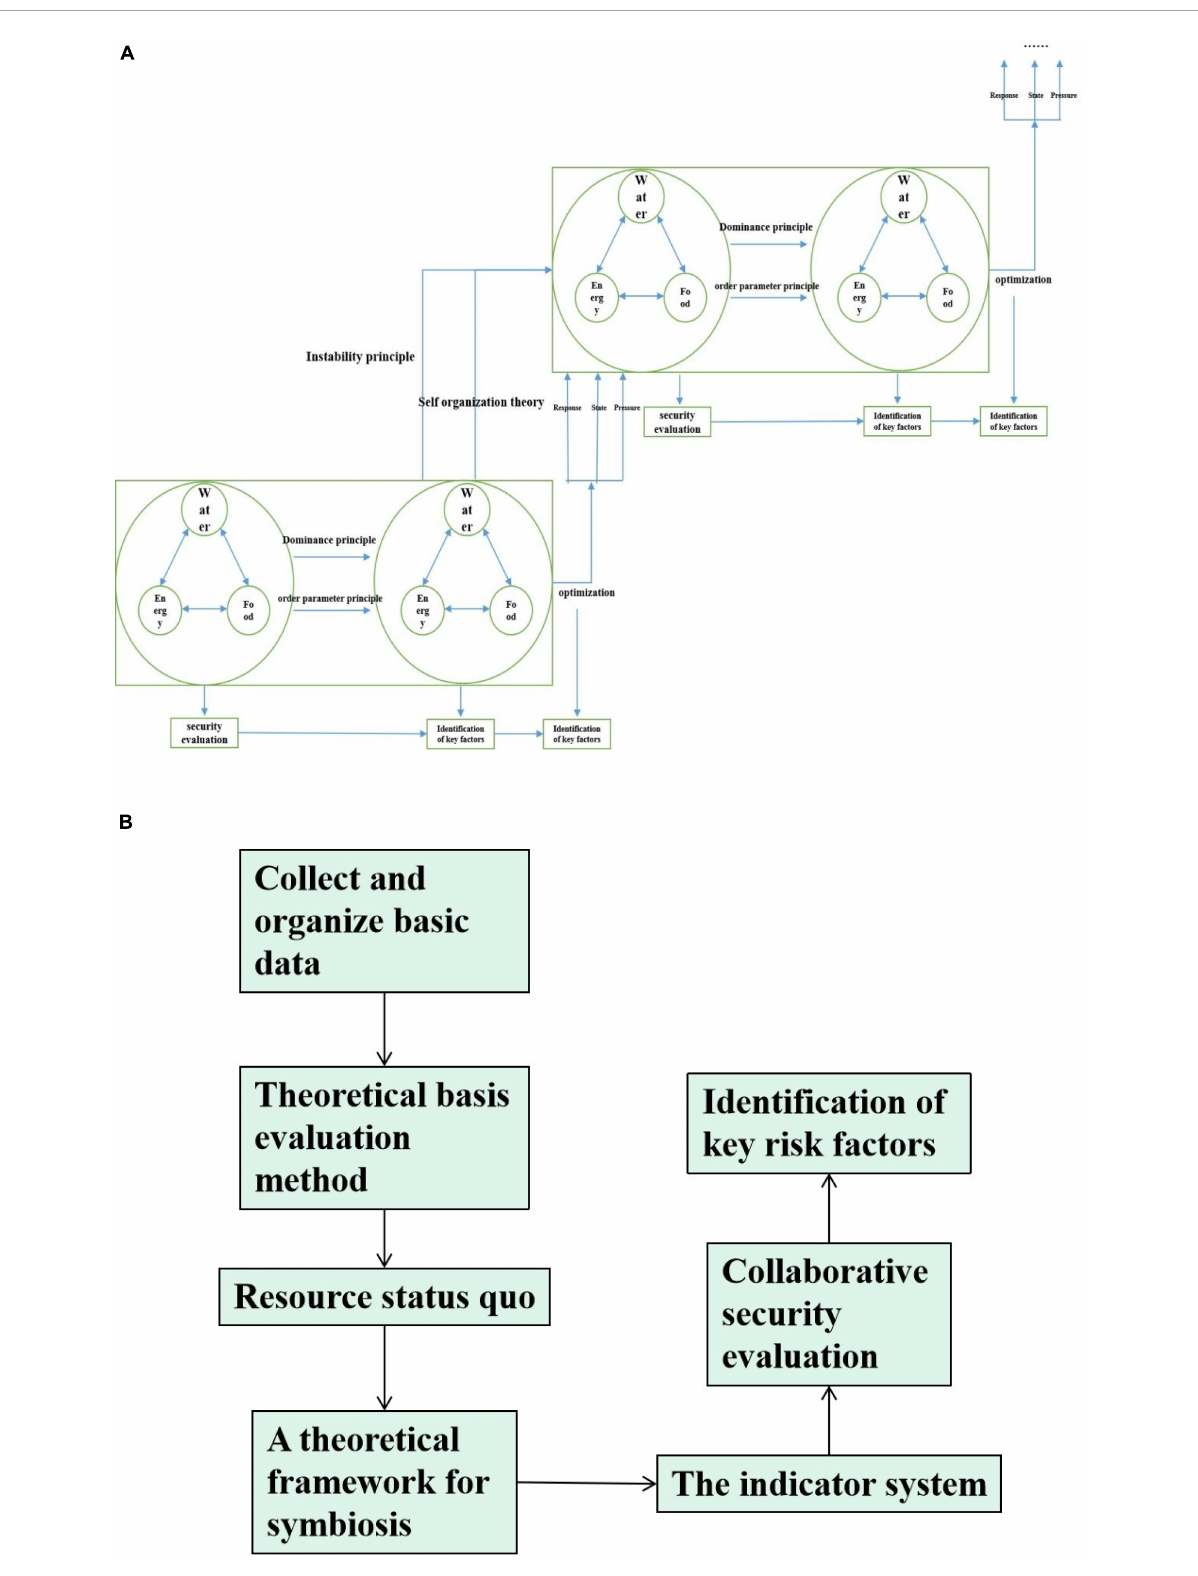
FIGURE1 (A) dynamic frame of collaborative security of water-energy-food related system. (B) Technology roadmap.